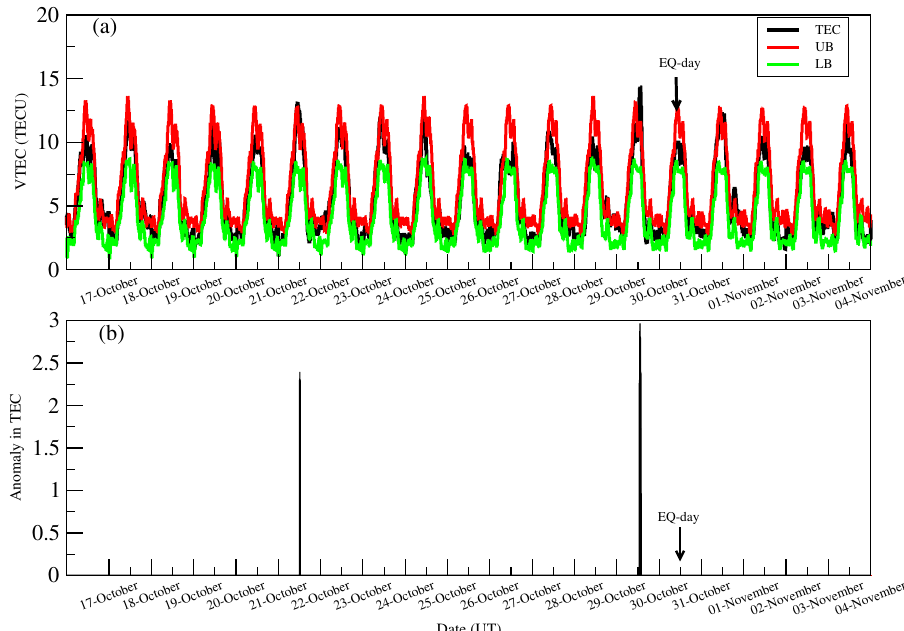
Figure 4. Same ( a , b ) as Figure 3, but for IZMI station.